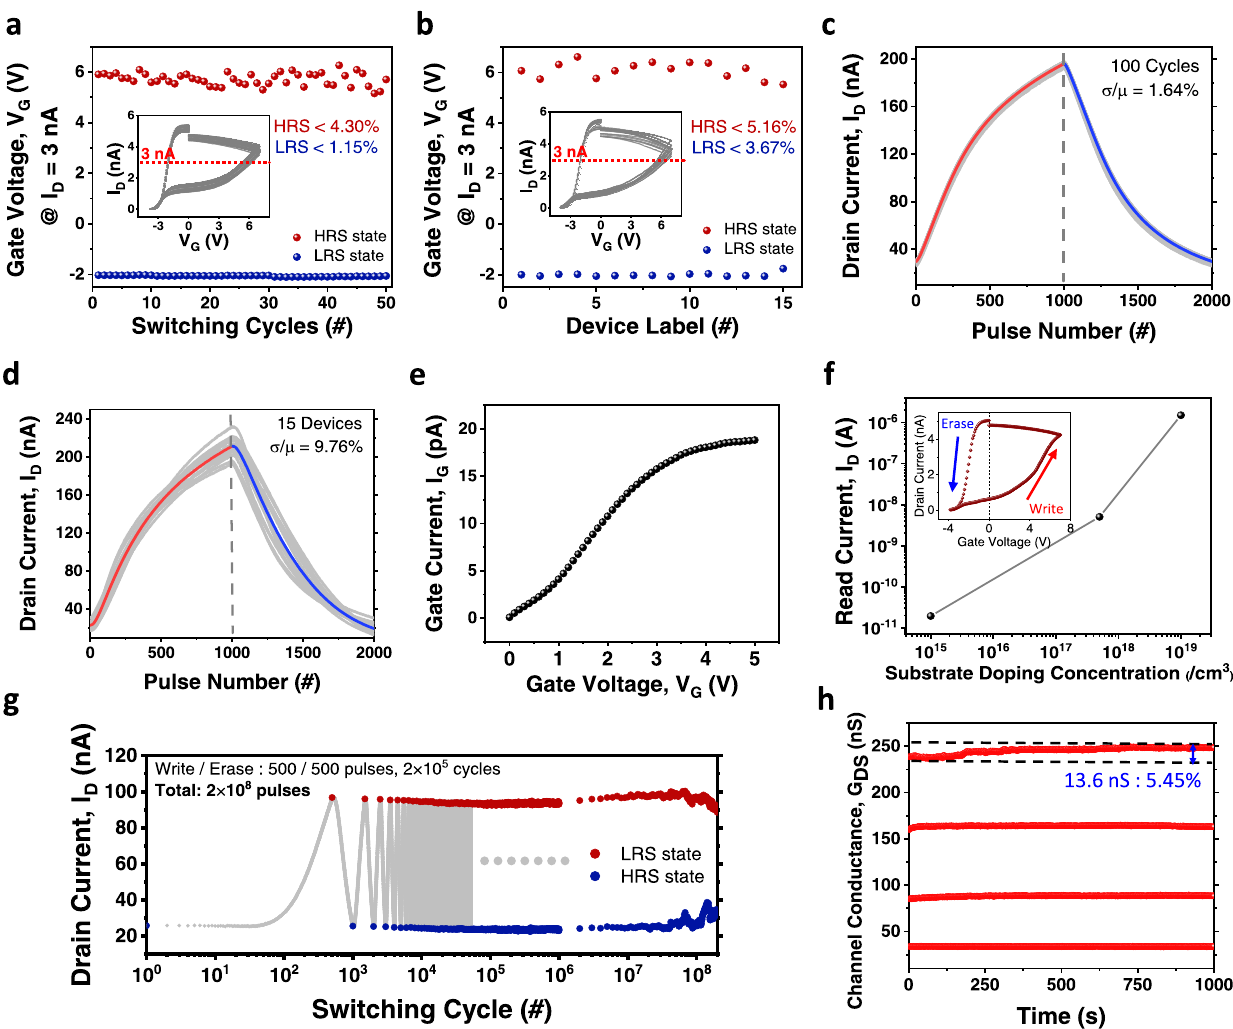
Fig. 3 | Measured GIFET data for high performance in a crossbar-array struc- ture. Selected gate voltages based on reaching a constant current (3nA) in I D -V G characteristics. Gate voltage was double sweptfrom − 4V to 7V,and 50 cycles in a single device ( a ) and 15 different devices with the same gate width and length ( b ) were measured. Insets are based on data from Supplementary Fig. 12. c Repeated LTP-LTD characteristics on a single GIFET device with 1000 potentiation – 1000 depression (5V/ − 3.3V, 500 μ s). d LTP-LTD characteristics for 15 different devices with 1000 potentiation – 1000 depression (5V/ − 3.3V, 500 μ s). The cycle-to-cycle and device-to-device variations of GIFET are 1.64% and 9.76%, respectively. e I G -V